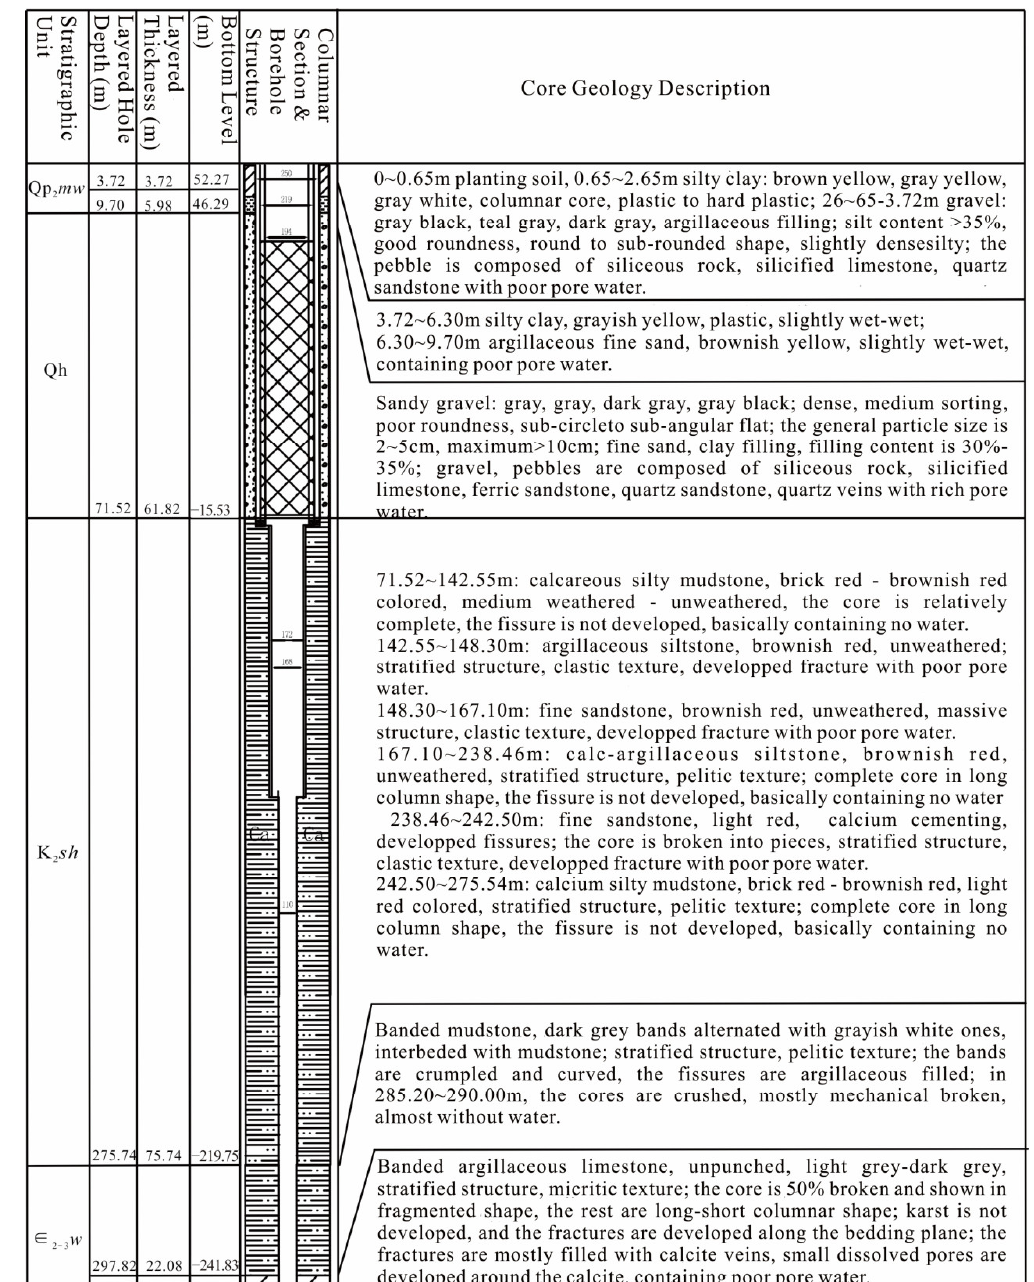
Figure 6. sk10 drilling core cataloguing results.